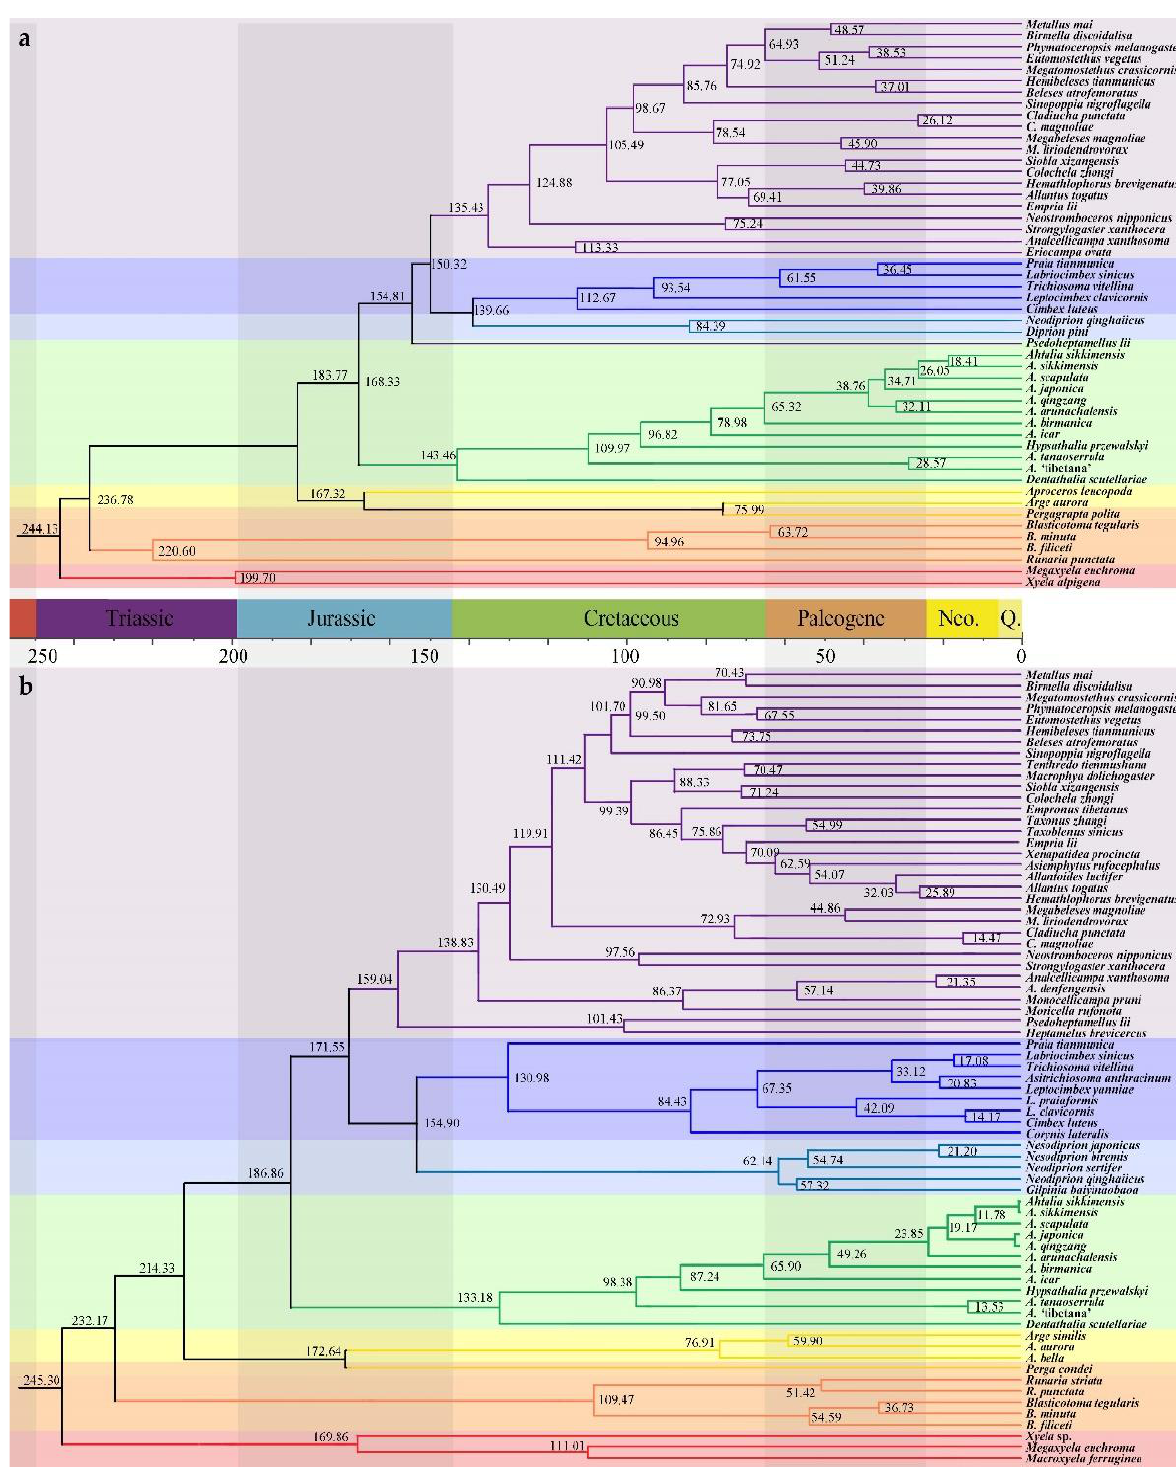
Figure 6. Age estimation trees using the dataset of ( a ) mtDNA; and ( b ) SCOs, highlighting the early diversity of Athaliidae constrained to the pre-Cretaceous.